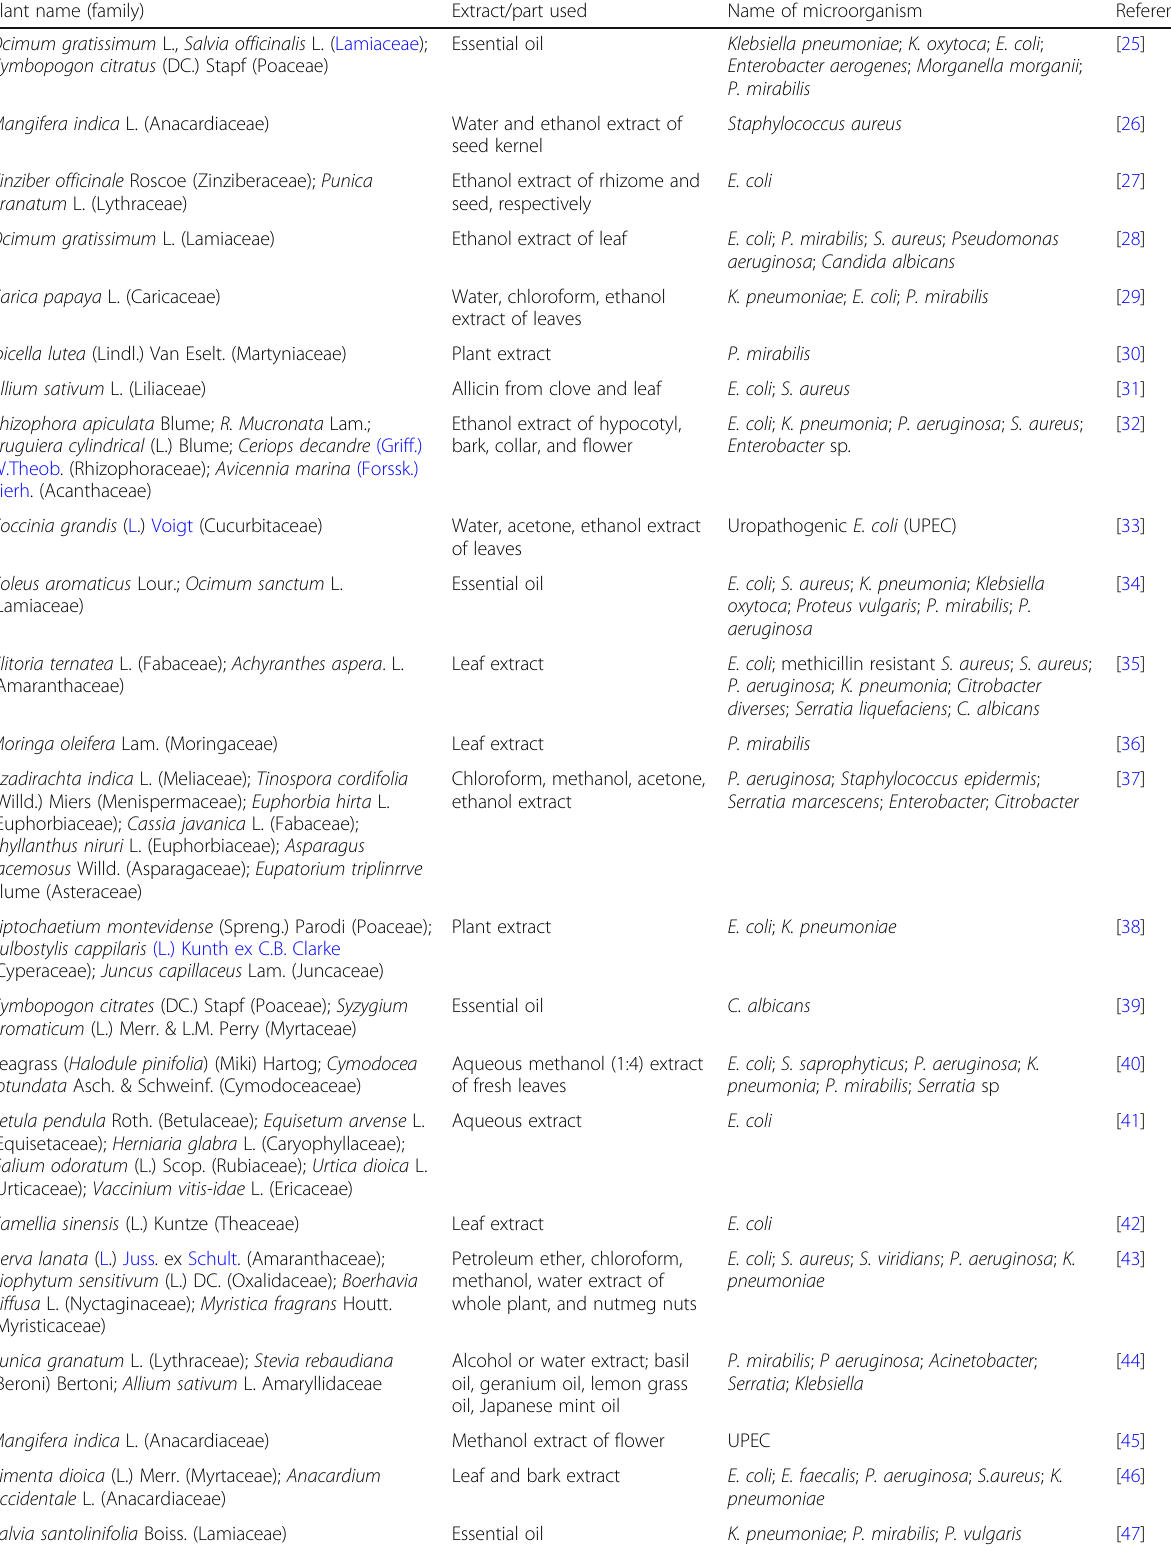
Table 2 List of medicinal plants with anti-uropathogenic potential Plant name